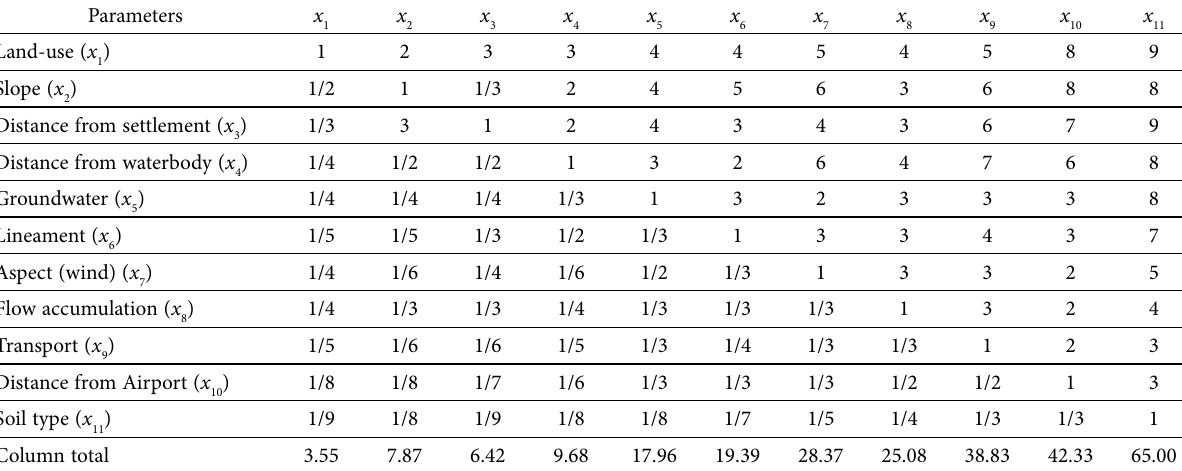
Table 2a. Comparison matrix for the site selection criteria Para